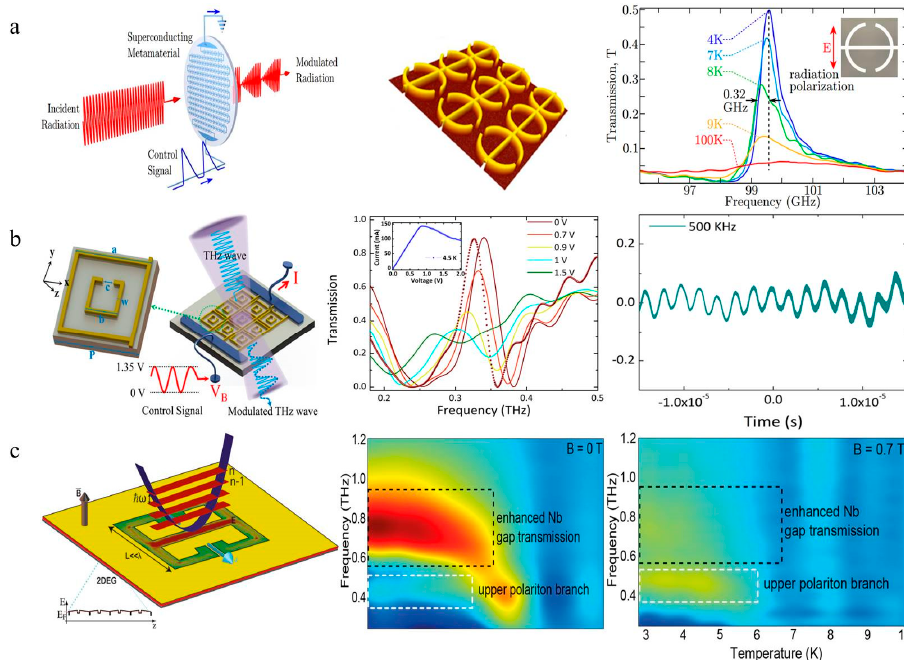
Figure 15. ( a ) A superconducting terahertz electrical modulator with a 100 kHz modulation rate based on the Fano resonance [172], copyright Physical Review Letters, 2012. ( b ) A superconducting terahertz modulator based on the electromagnetic induction transparent metamaterials [20]. ( c ) The light-matter coupling experimental device. The transmission of the switchable THz superconducting metasurface on a 2DEG changes by varying frequency and temperature [173], copyright Springer Nature, 2017.